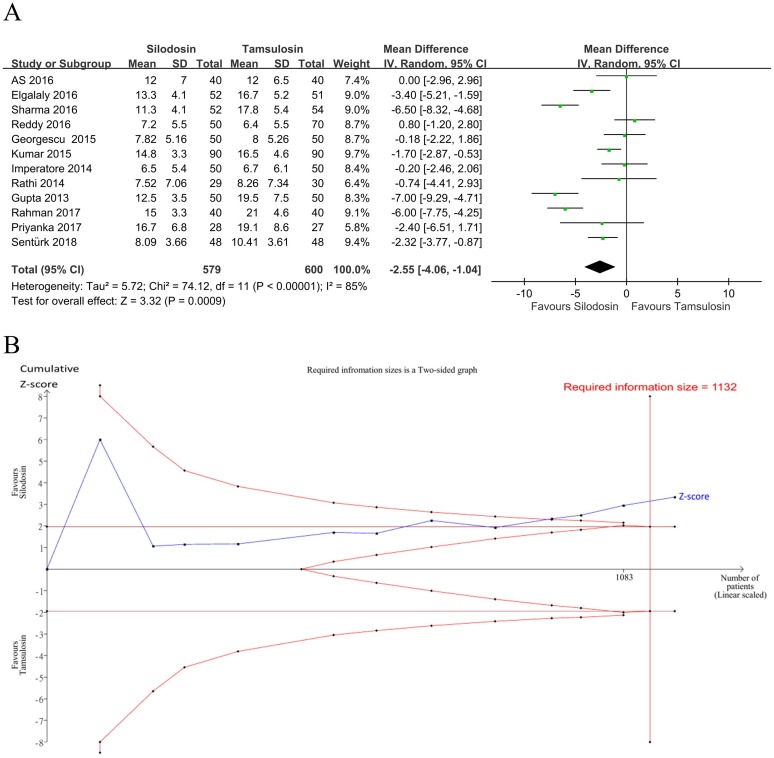
Forest plot and trial sequential analysis for stone expulsion times.A: Forest plot. MD, mean difference; CI, confidence interval. B: Trial sequential analysis of the effect of silodosin on the expulsion time compared to tamsulosin. The risk of a type 1 error was maintained at 5% with a power of 90%. The variance was calculated from data obtained from the included trials. A clinically significant anticipated mean difference in expulsion times was set to 2.55 days based on the pooled result of our meta-analysis. The result showed that solid evidence indicated that silodosin had a shorter expulsion time compared to tamsulosin.